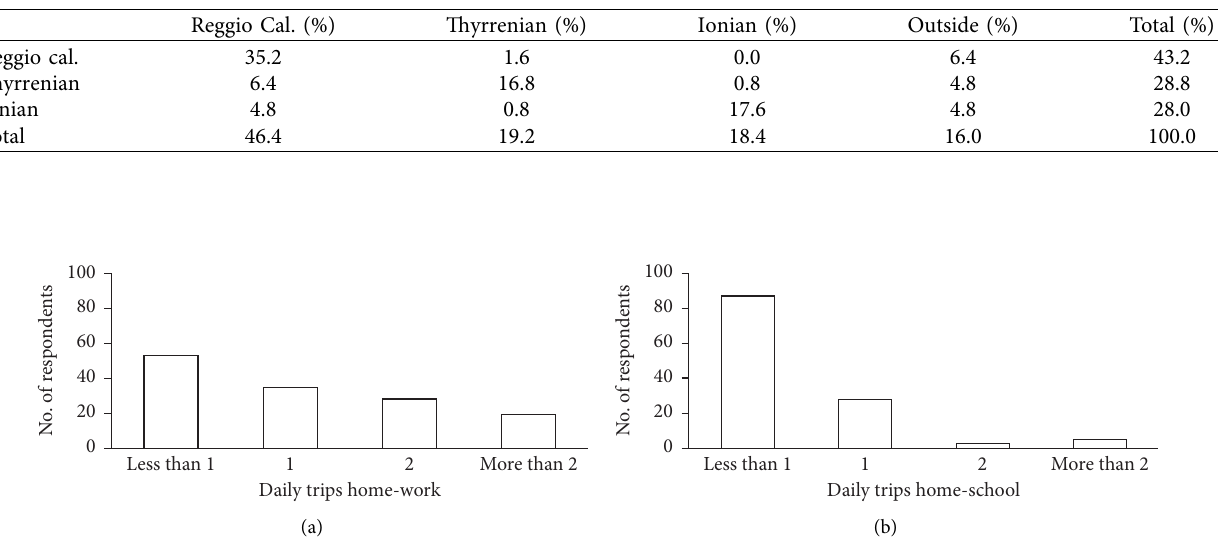
Table 1: Home-work and home-school OD matrix (%) of the sample.